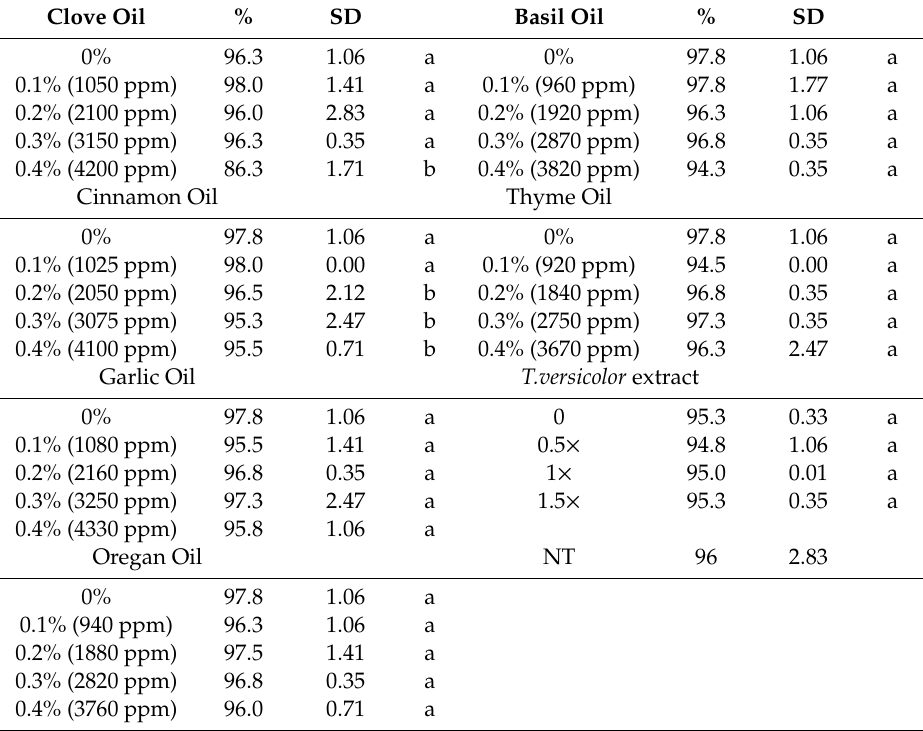
Table 2. Influence of essential oils (EOs) and Trametes versicolor extract (Tve) on healthy tomato seeds germination percentages: experimental average and standard deviation